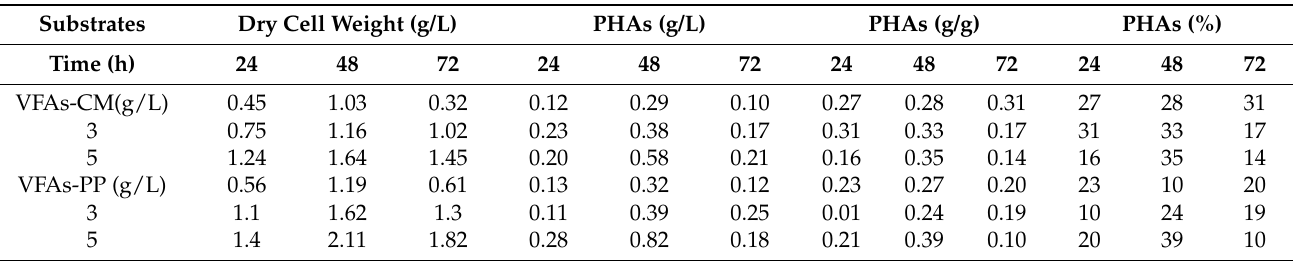
Table 3. Dry cell weight and PHAs accumulation by Pseudomonas oleovorans at varied concentrations of VFAs-rich streams used in this study. Volatile fatty acids stream from Potato peels.